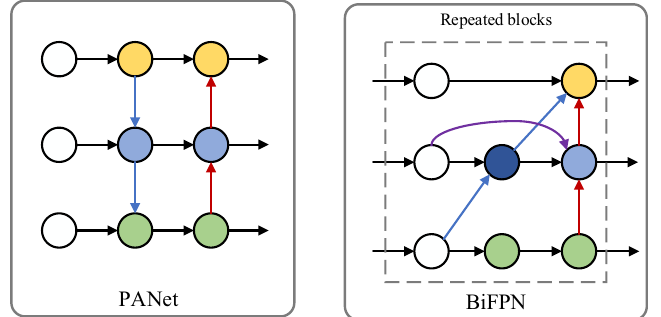
Fig. 6 Structure of PANet and BiFPN